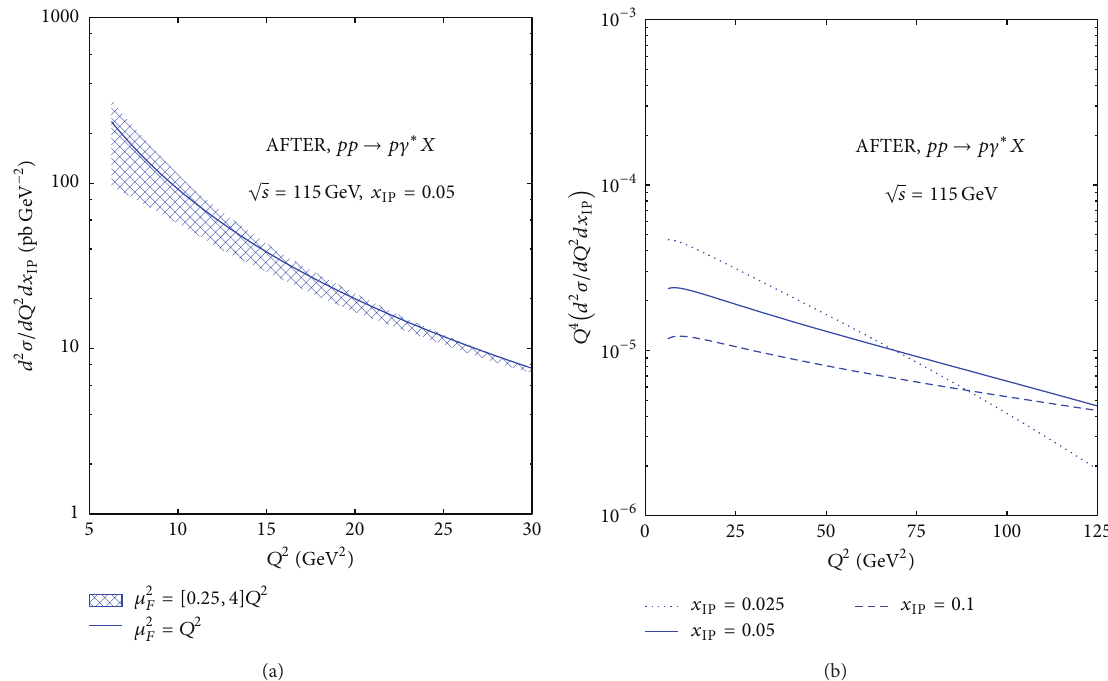
Figure 5: (a) Double differential cross sections for the production of a Drell-Yan pair at 𝑥 IP = 0 . 05. Blue error bands represent theoretical errors estimation, as described in the text. (b) Double differential cross sections times 𝑄 4 for three different 𝑥 IP -values.